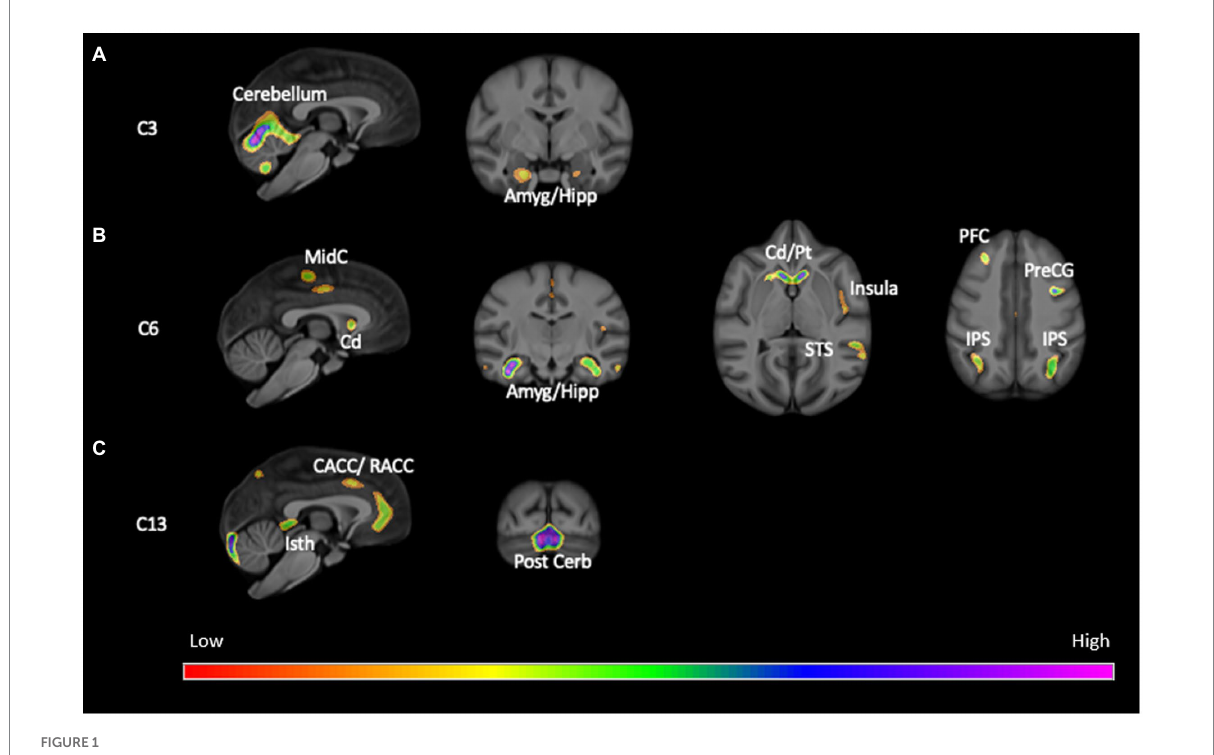
FIGURE 1 Screen shots of brains regions within (A) Component 3, (B) Component 6, and (C) Component 13. Cd, caudate; Pt, putamen; Amyg/ Hipp, amygdala and hippocampus; insula, insula; STS, superior temporal sulcus; IPS, intraparietal sulcus; PFC, prefrontal cortex; PreCG, precentral gyrus; CACC/RACC, caudal and rostral anterior cingulate cortex; Isth, isthmus of the cingulate; MidC, mid-cingulate; Cerb, cerebellum; Post Cerb, posterior cerebellum. The colors indicate standardized z-values from the SBM component scores.